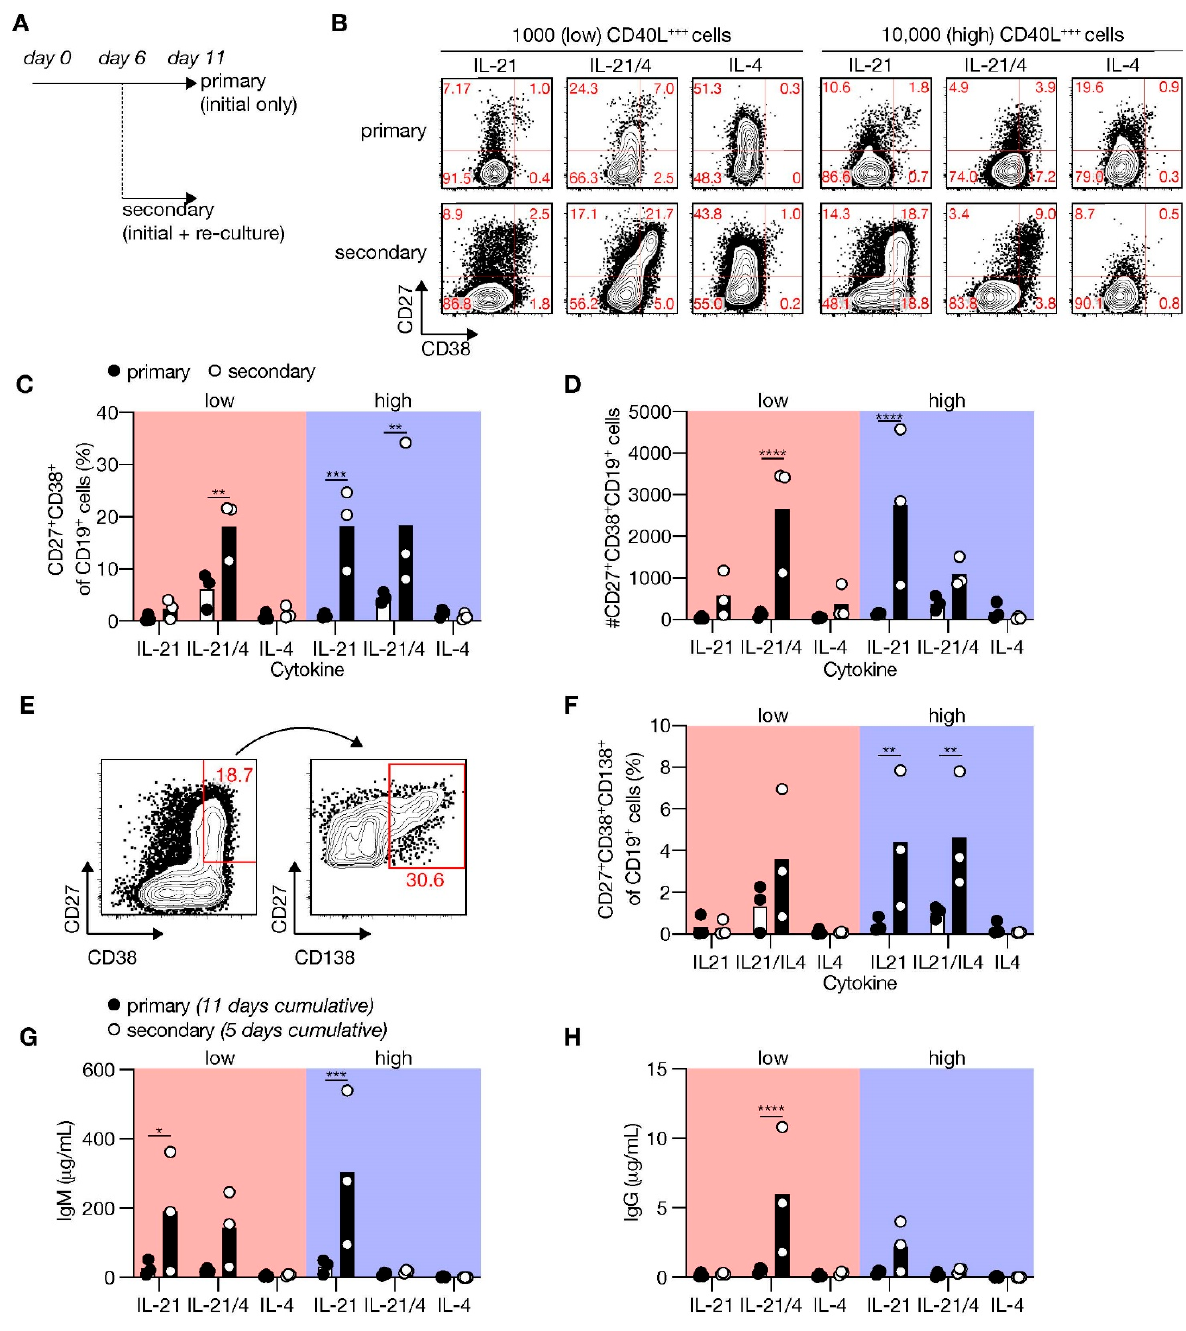
Figure 4. Renewed CD40 costimulation and Tfh cytokines induce in vitro differentiation of human naive B-cells into antibody-secreting cells (ASCs). ( A ) Human B-cells cultured on 1000 (low; supplemented with 9000 WT 3T3 cells) or 10,000 (high) CD40L +++ -expressing 3T3 cells (as in Figure 1A) with or without IL-21 and/or IL-4 for 11 days (primary—initial only stimulation). Alternatively, primary cultures were harvested after 6 days, and secondary cultures were initiated for 5 days with the same number of CD40L +++ -expressing 3T3 cells and similar cytokine environments as in the primary culture. ( B ) Representative of FACS plots showing CD27 and CD38 expression among human B-cells cultured as in A. ( C , D ) The frequency ( C ) and number ( D ) of CD27 + CD38 + cells were analyzed 11 days after initial only, or initial + secondary culture. ( E ) Representative plots of CD138 expression within the CD27 + CD28 + ASC population. ( F ) The frequencies of CD138 + plasma cells were determined 11 days after initial only or initial + secondary culture. ( G , H ) Cumulative secretion of IgM ( G ) and IgG ( H ) measured in culture supernatants 11 days after initial only or 5 days after initial + secondary culture. Each data point represents the mean of an individual experiment ( n = 3) with triplicate measurements. Mean values are represented as bars. p -values were calculated using multiple t-tests. * P ≤ 0.05, ** P ≤ 0.01, *** P ≤ 0.001, **** P ≤